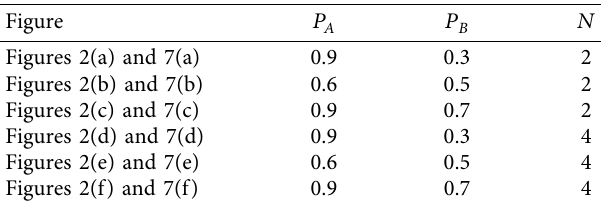
Table 1: The settings of the reward probabilities of slot machines ( P A and P B ) and the parameter N that specifies the number of threshold levels (2 N